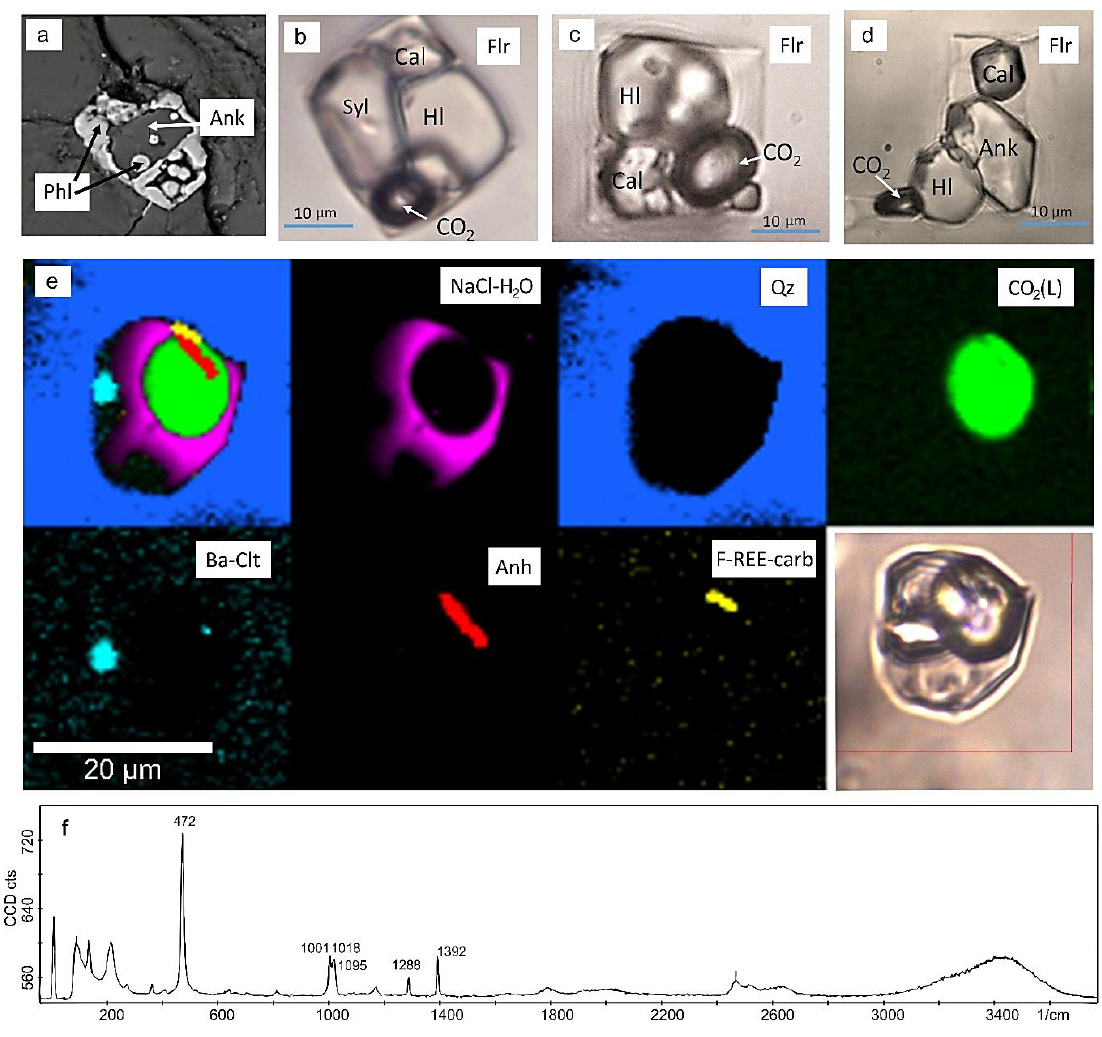
Figure 3. The composition of melt inclusions in carbonatites from the Central Tuva Region of Southern Siberia. Backscattered electron (BSE) image of an exposed melt inclusion ( a ), as well as microphotographs of brine – melt inclusions ( b – d ) in fluorite of ankerite – calcite carbonatites. Raman spectroscopy ( e , f ) showing the compositional mapping of a brine – melt inclusion in quartz from the Fe-F-Ba-Sr-REE-bearing siderite carbonatites.